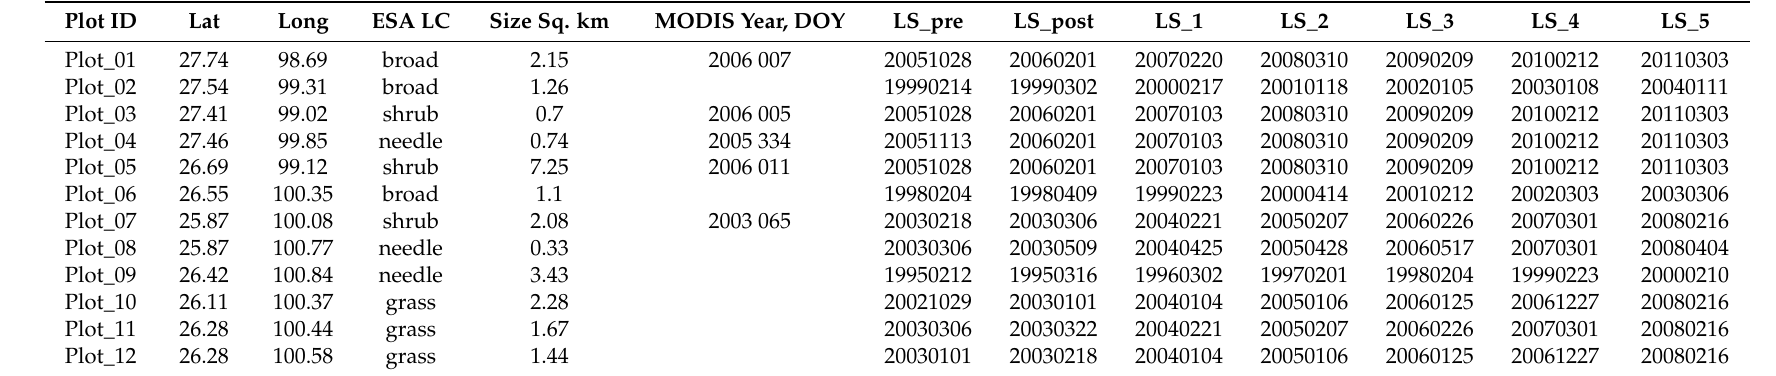
Table 1. Landsat TM time series for the 12 selected burn plots. Locations of the burn plots are indicated with the geographic coordinates of their center,